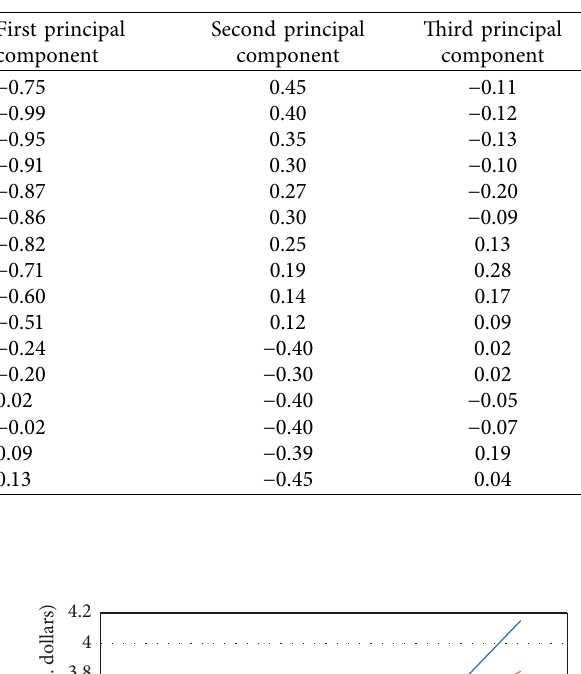
Table 4: PSO optimization weight.